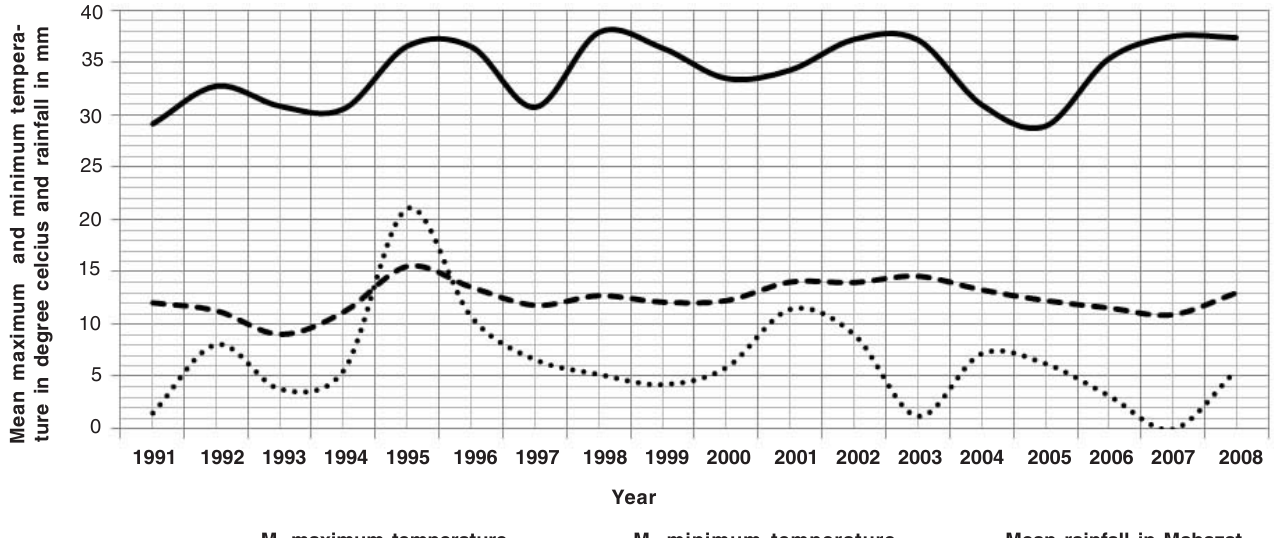
Figure 2. Mean maximum and minimum temperature and rainfall in mm from 1991 to 2008 in Mahazat as-Sayd Protected Area, Saudi